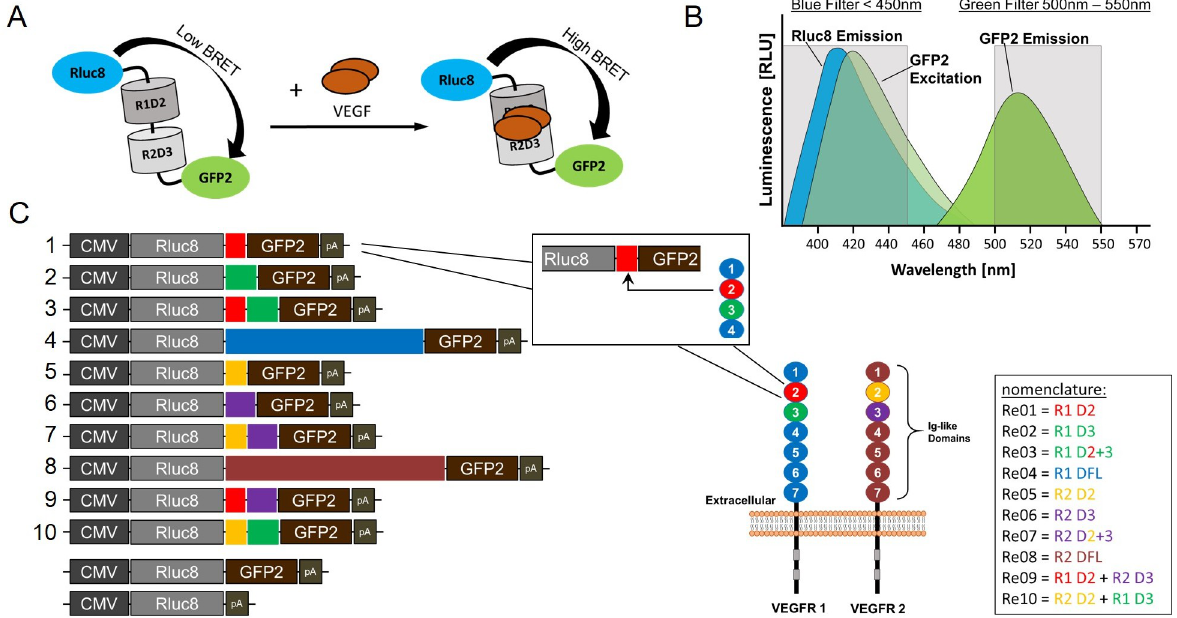
Fig 1. eBRET2 VEGF biosensors. (A) VEGF quantification method of the eBRET2 VEGF biosensor. A conformational change after VEGF binding leads to an increased energy transfer and thus to a higher BRET signal, in dependence of the VEGF concentration. (B) Overlapping Rluc8 emission wavelength and GFP2 excitation wavelength generates GFP2 emission at higher wavelength. (C) Biosensor expression constructs Re01–Re10. CMV = cytomegalovirus Promoter, Rluc8 = Renilla luciferase, R = VEGF receptor, D = IgG domain, GFP2 = green fluorescent protein, pA = polyadenylation signal. VEGF receptor 1 (R1) and 2 (R2) structure. The receptors contain a transmembrane-, an intracellular catalytic domain and 7 extracellular IgG like domains. IgG like domain 2 (D2) and 3 (D3) are responsible for the VEGF binding and were introduced between the Rluc8 and the GFP2 as VEGF binding